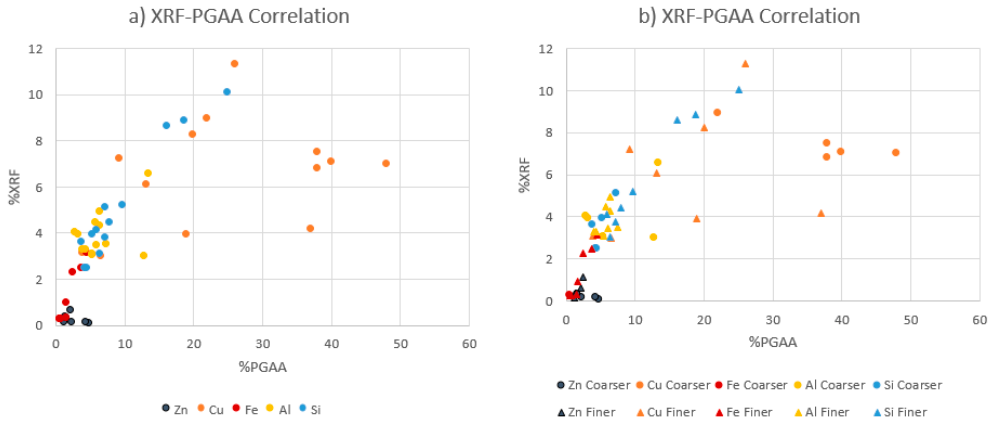
Figure 1. ( a ) Correlation between XRF and PGAA for the complete dataset of the major metals of PCB particles ( b ) The dataset is divided into two series, the coarser (0.5–4 mm) and finer fractions ( − 0.5